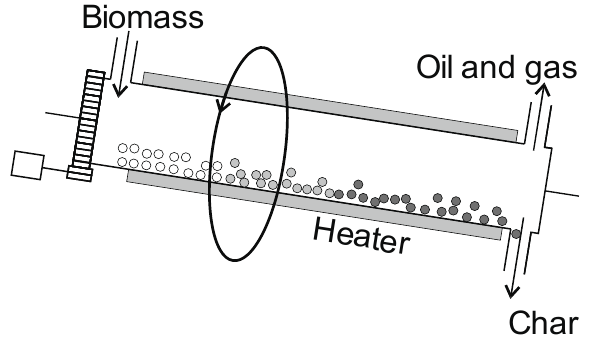
Figure 10. Rotary drum pyrolysis reactor.